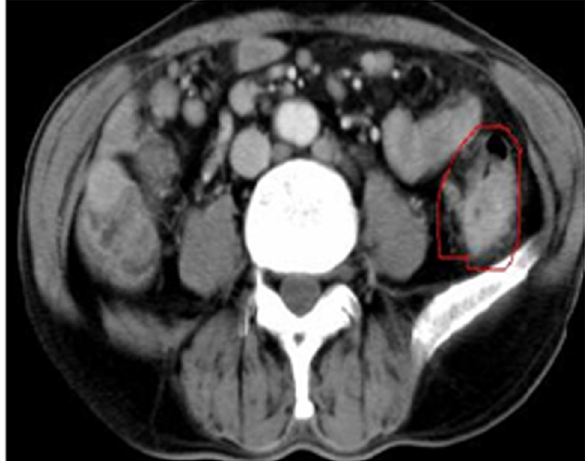
Figure 1: Abdominal CT indicating a mass lesion of the colon before